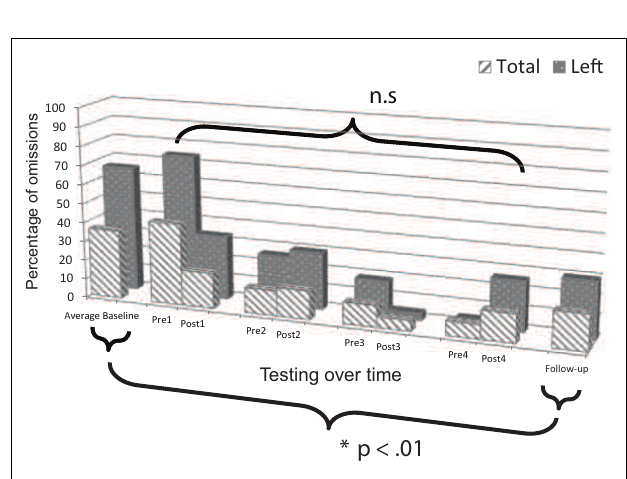
p = 0.263 ( Figure 7 ). Performance was in the normal range on the test as evidenced by omitting a total of only one target three times during the study including before session one (Pre1), after session two (Post2), and at follow-up.